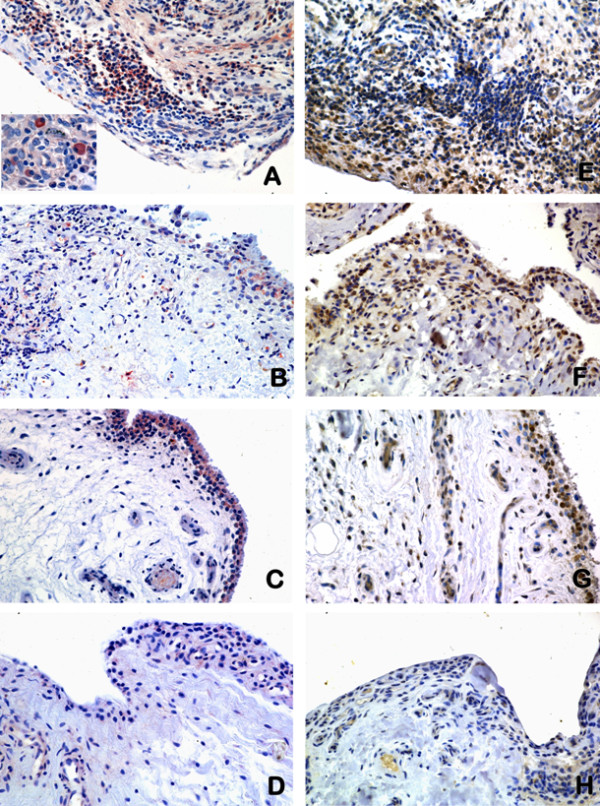
Immuhistochemical staining of TWEAK and Fn14 in various synovia. Expression of TWEAK (indicated by red, left) and Fn14 (indicated by brown, right) in active RA (A, E), inactive RA (B, F), OA (C, G) and normal synovial tissue (D, H). Insert in panel A is TWEAK expression by cells with resembling plasma cell-like morphology. All sections were counterstained with haematoxylin. Images were obtained using a 20× objective.